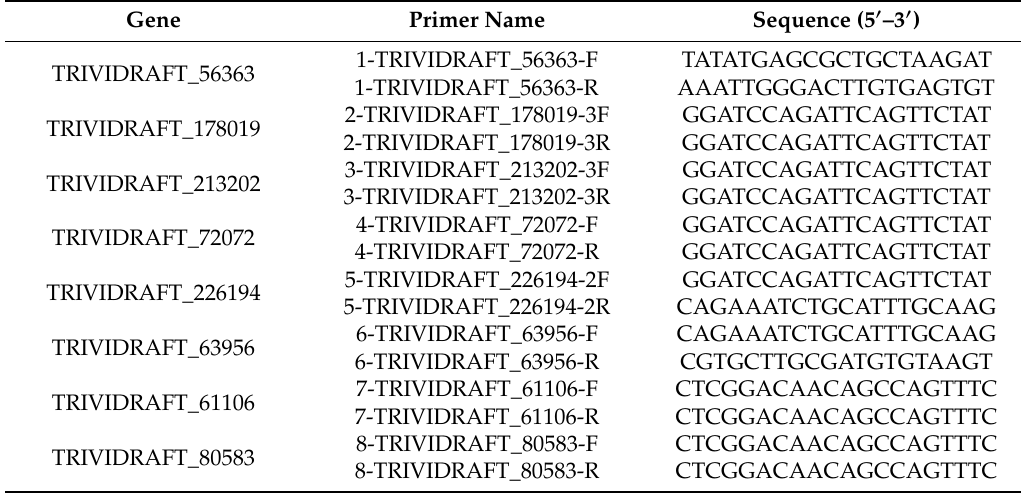
Table 1. qRT-PCR primer sequences.